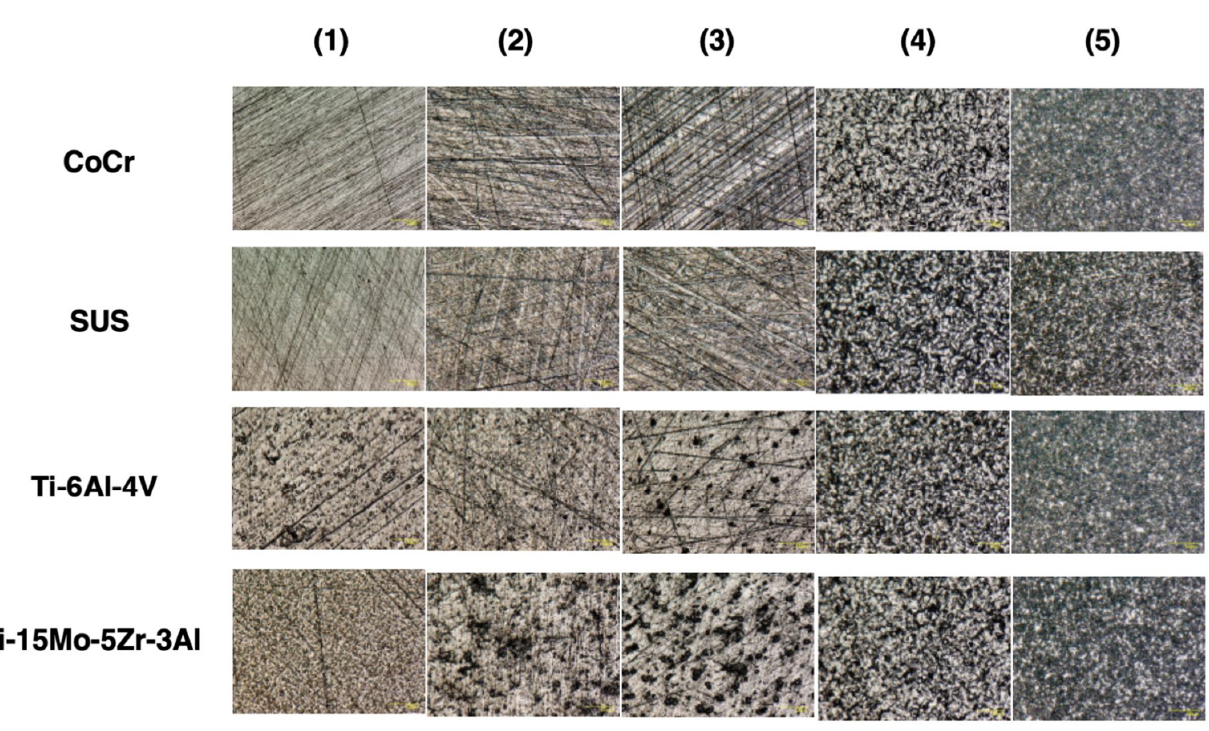
Figure 1. Photograph of the surface using a digital microscope (VHX-6000; KEYENCE Co., Osaka, Japan) (original magnification × 500).